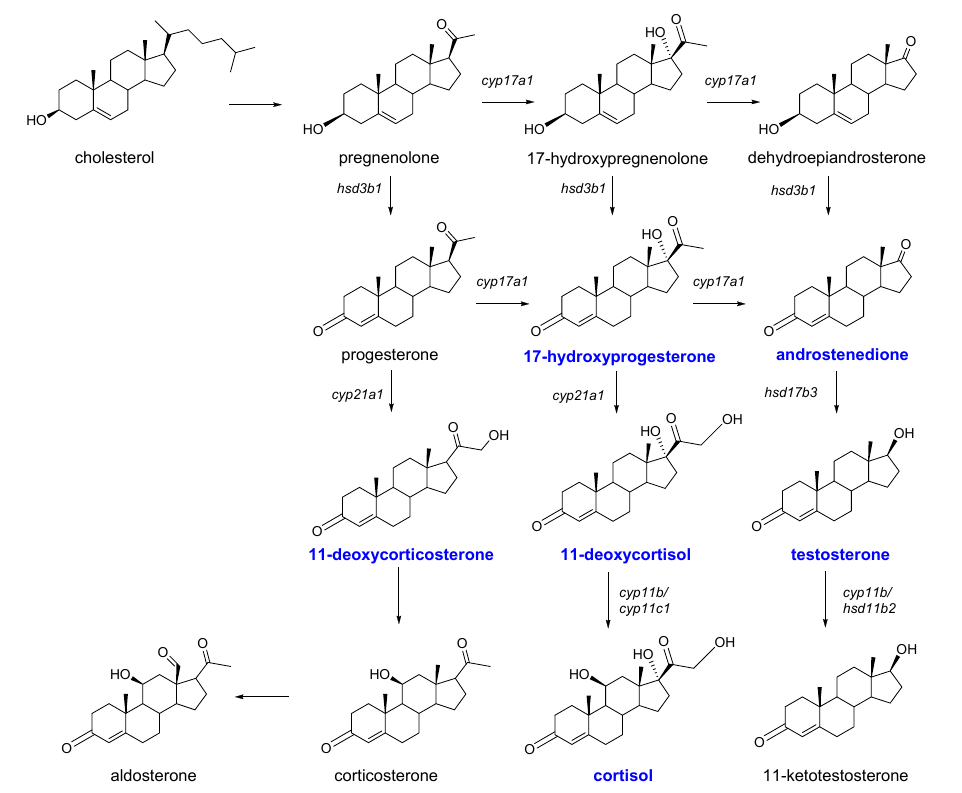
Figure 1. The plausible biosynthesis pathways of steroid hormones in a teleost [3]. The metabolites marked in blue are the analytes in this analysis method.